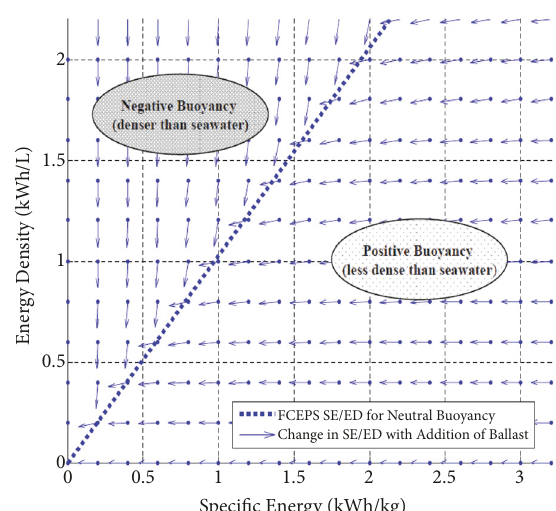
Figure 24: Monthly average electric production.